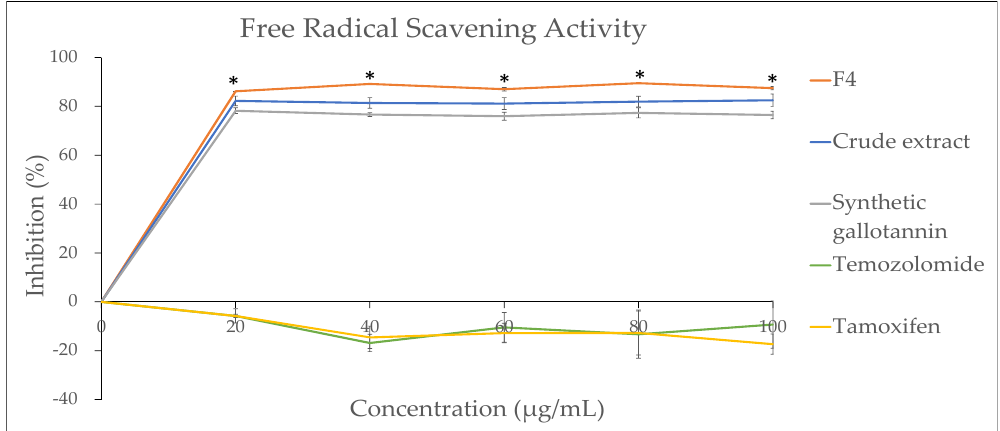
Figure 6. Free radical scavenging activity analysis for QI gall extract before fractionation (crude extract) and after fractionation (F4), along with the synthetic gallotannin compound and chemo-drugs (Temozolomide and Tamoxifen) (* p < 0.05 for F4 vs. all other groups).